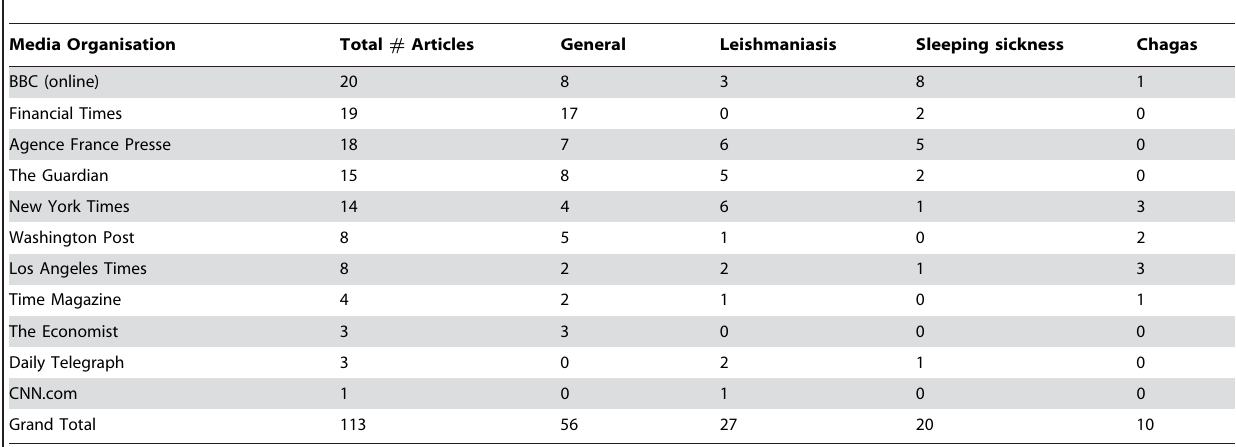
Table 1. Articles found for each news